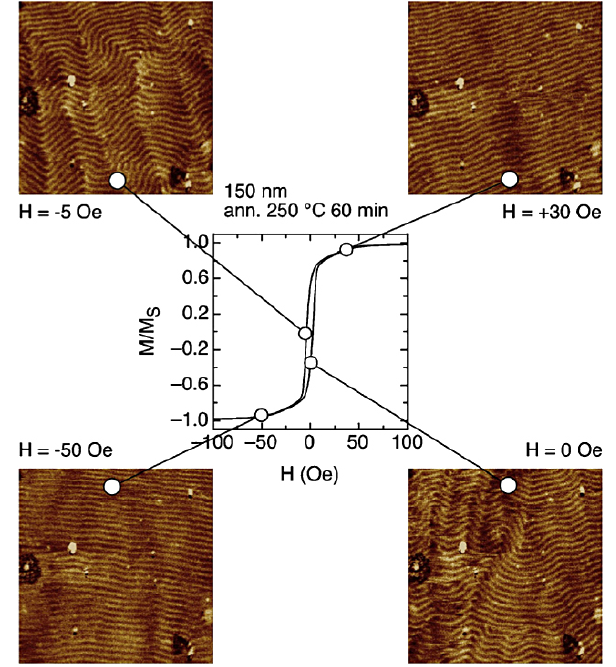
Figure 9. Hysteresis loop of the 150nm thick film annealed at 250 ◦ C for 60min. Selected MFM images are shown, which are taken at different applied field values. The corresponding point of the hysteresis loop is indicated (Coïsson et al., 2009). (Non-SI units are in the original publication: 1Am − 1 ∼= 0.0126Oe.) The speci- men was a sputtered FeSiB amorphous film. Reproduced with per- mission of the copyright owner.